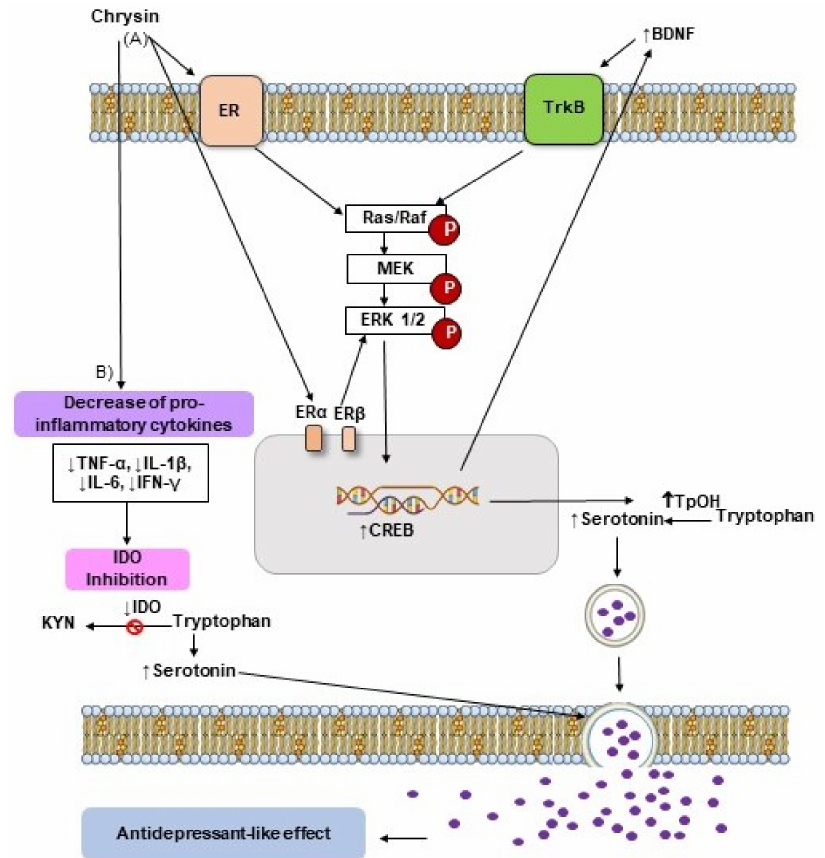
Figure 3. Possible mechanisms of action involved in the antidepressant-like effect of chrysin. ( A ) The flavonoid chrysin can modulate ER α and ER β of membrane, which triggers the MAPK/ERK1/2 sig- naling pathway involved in phosphorylation and subsequent CREB activation ( ↑ CREB), which promotes the increase of BDNF levels ( ↑ BDNF) [11,19,20,43], which can further activate the MAPK/ERK1/2 signaling by the TrkB interaction [56]. The above-mentioned pathway also pro- motes an increase of TpOH expression ( ↑ TpOH) and serotonin levels ( ↑ Serotonin) resulting in the antidepressant-like effect [12,25]. ( B ) Furthermore, chrysin can decrease the pro-inflammatory cytokine levels ( ↓ TNF- α , ↓ IL-1 β , ↓ IL-6, ↓ IFN- γ ), which inhibits IDO activity ( ↓ IDO) improving sero- tonergic neurotransmission and producing its antidepressant-like effect [25]. ER = estrogen receptor; MAPK = mitogen-activated-protein-kinases; CREB = cAMP response element binding; BDNF = brain derived neurotrophic factor; TrkB = tropomyosinreceptor kinase B; TpOH = tryptophan-hydroxylase; TNF- α = tumor necrosis factor- α ; IL-1 β = interleukin 1 beta; IL-6 = interleukin 6; IFN- γ = interferon gamma; IDO = indoleamine 2,3-dioxygenase; ERK1/2 = extracellular signal-regulated kinase 1 and 2; KYN = kynurenine. (Figure was prepared by the